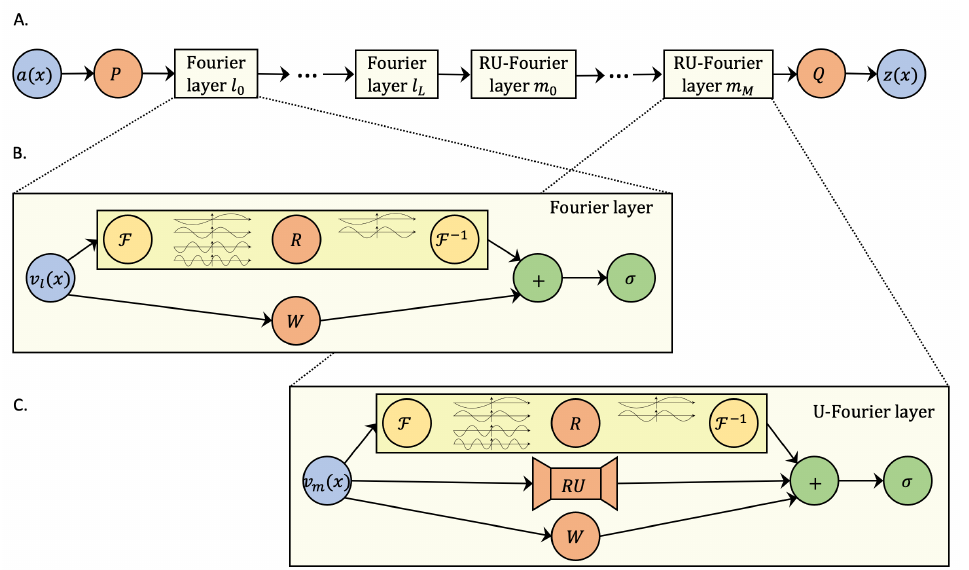
Figure A1. ( A ) The RU-FNO model architecture. ( B ) In each Fourier layer, the input data are lifted from the physical space to an infinite-dimensional space. The transformations in the FNO are performed via the FFT and inverse FFT. ( C ) RU-Fourier layers contain an additional series of RU convolutions in parallel with the FNO. The addition of residual networks improves local convolution and helps the model learn higher-frequency trends in the data, such as the tip of a gravity-dominant plume; in particular, previous work has demonstrated the value of ResNets when used with CNNs for subsurface flow prediction [49]. This diagram is modified from Figure 2 of [30].